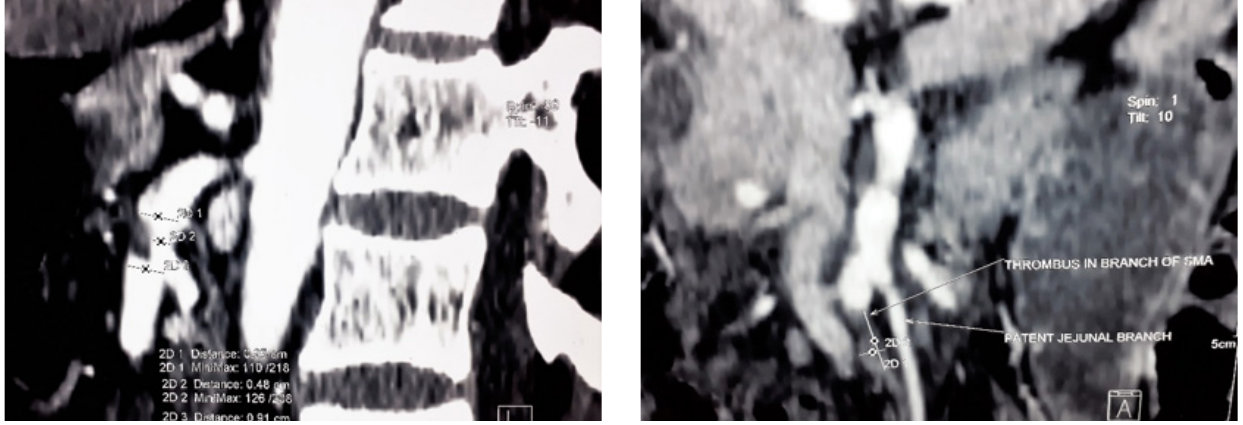
Figure 2 A and B : Computed Tomographic Angiography showing thrombus in the Superior Mesenteric